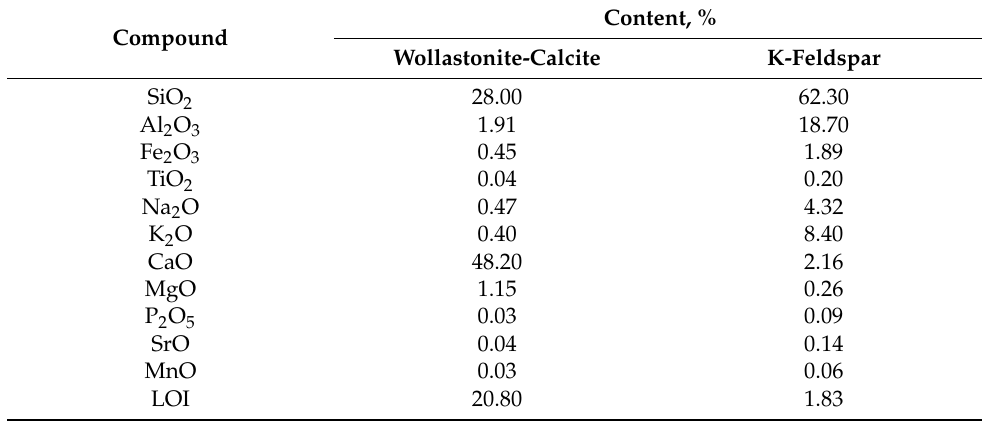
Table 1. Chemical analyses of the representative samples.